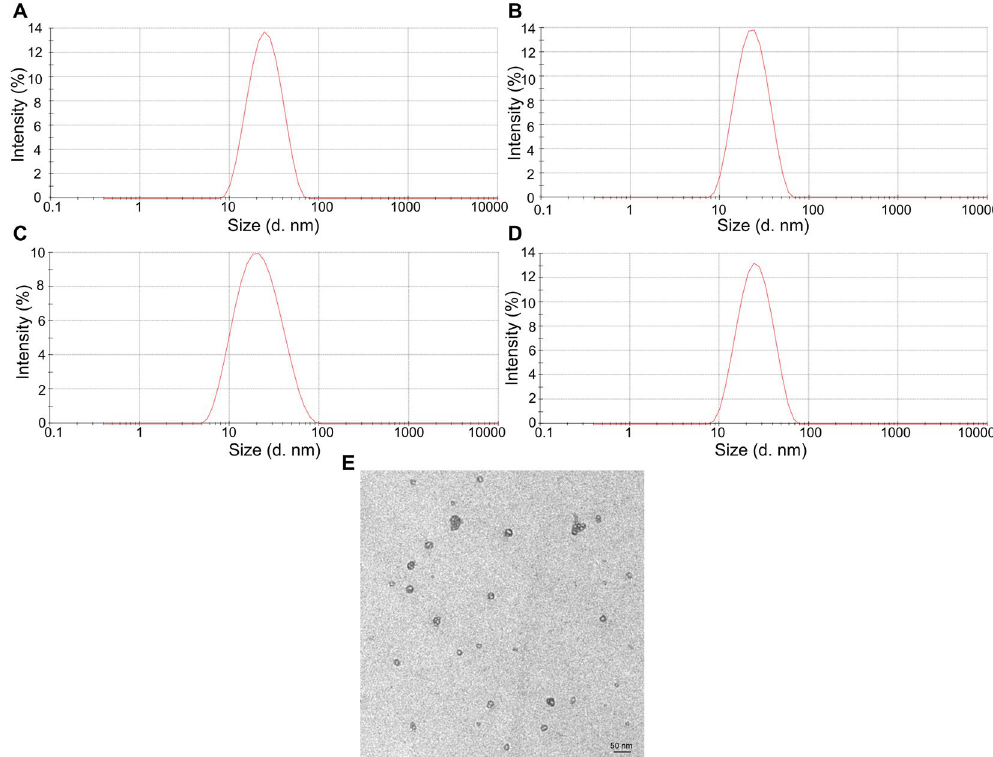
Figure 1. Particle size and size distribution of nanoparticles. Empty Pluronic F127 micelles ( A ); Empty FT micelles ( B ); DiR loaded FT micelles ( C ); Rho123 loaded FT micelles ( D ); TEM images of FT micelles ( E ). The scale bar represented 50 nm.